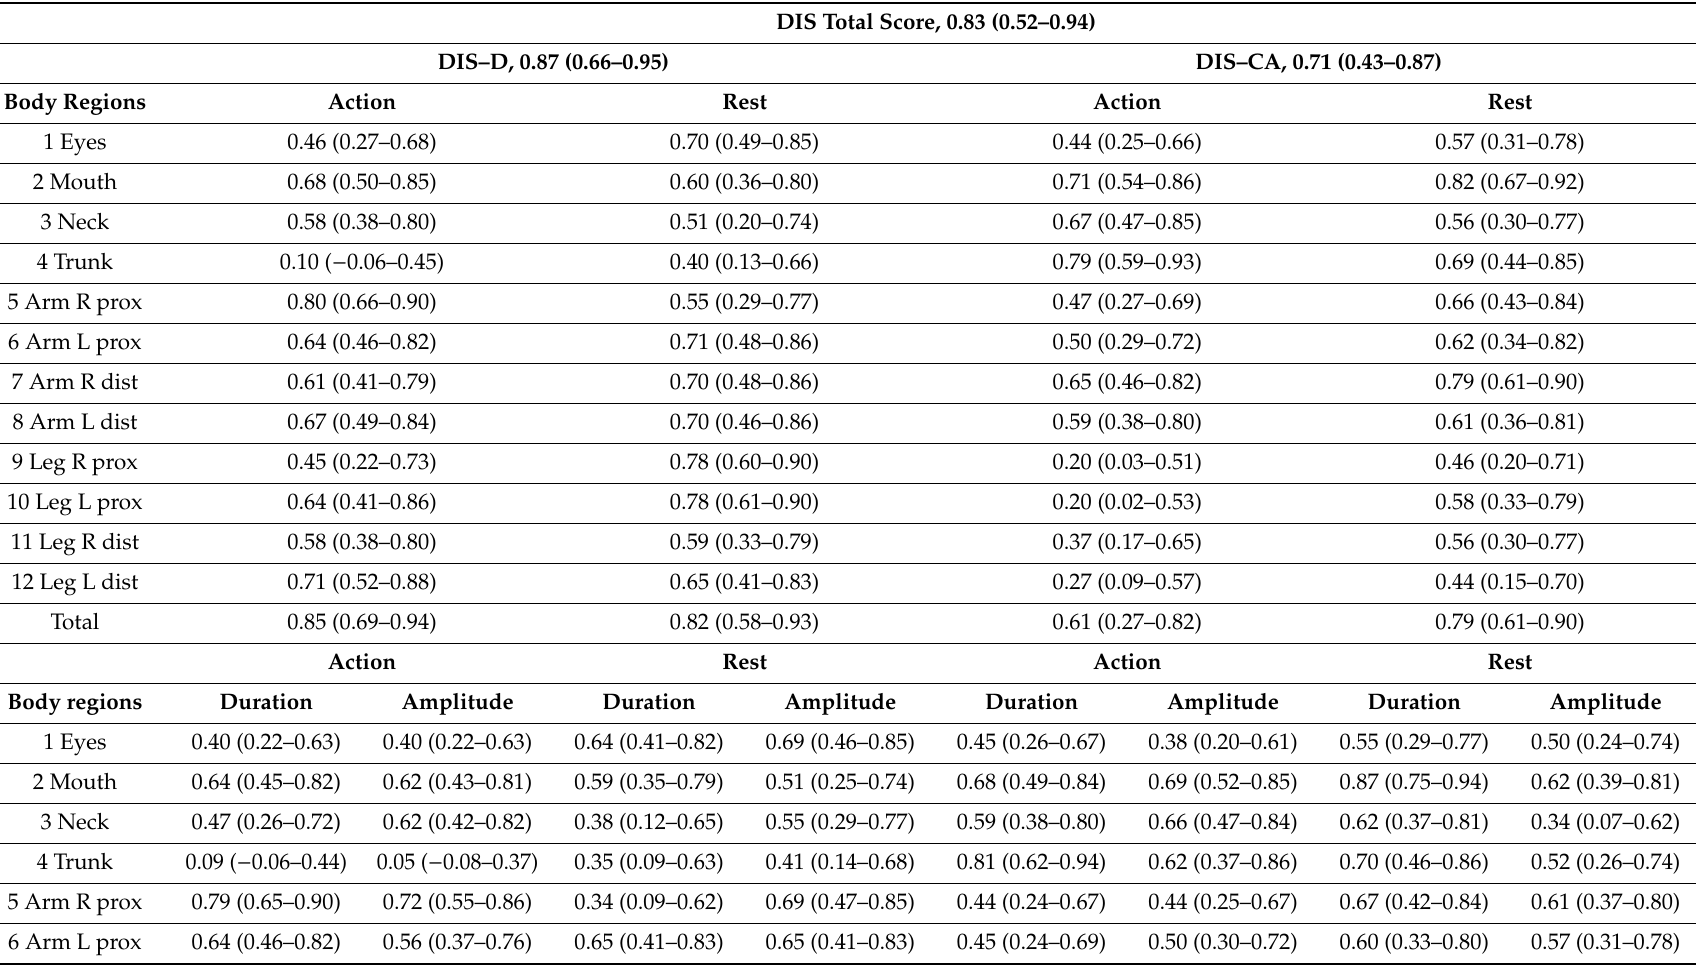
Table 1. Inter-rater reliability, intra-class correlation coe ffi cient (ICC) values and confidence intervals (Cis) of the Dyskinesia Impairment Scale (DIS), n =